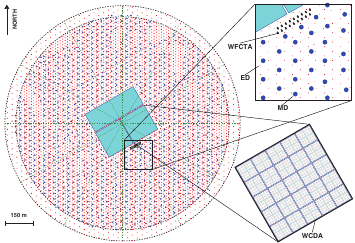
Figure 1. The layout of the scintillator counter (small dots) array, muon counter (big dots) array, water Cherenkov detector (rect- angle in the center) array and 18 wide field of view Cherenkov telescopes (small rectangles) in the LHAASO complex of multi- detector array of 1.3 km 2